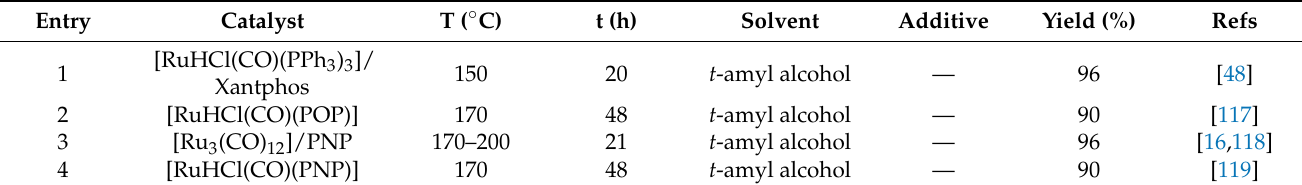
Table 6. Catalytic isohexides diamination using ammonia as a nitrogen source.